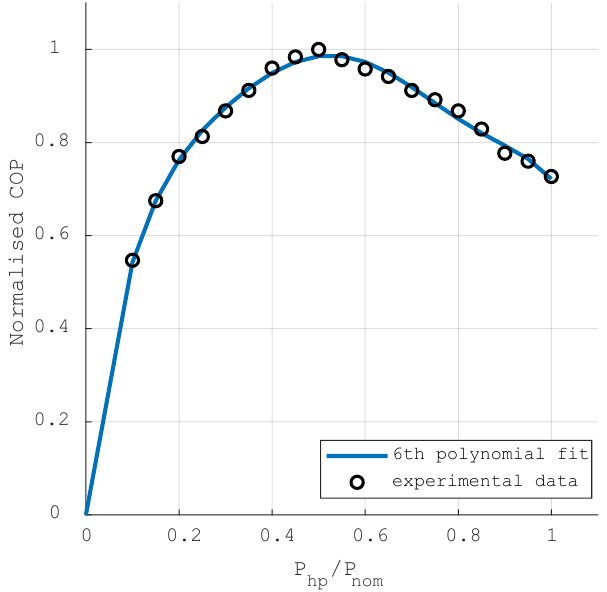
Figure A1. Sixth order polynomial fitting curve of COP correction factor ( f c ) vs. Normalized COP data. Polynomial fit : f c = a 6 · PLR 6 + a 5 · PLR 5 + a 4 · PLR 4 + a 3 · PRL 3 + a 2 · PRL 2 + a 1 · PRL